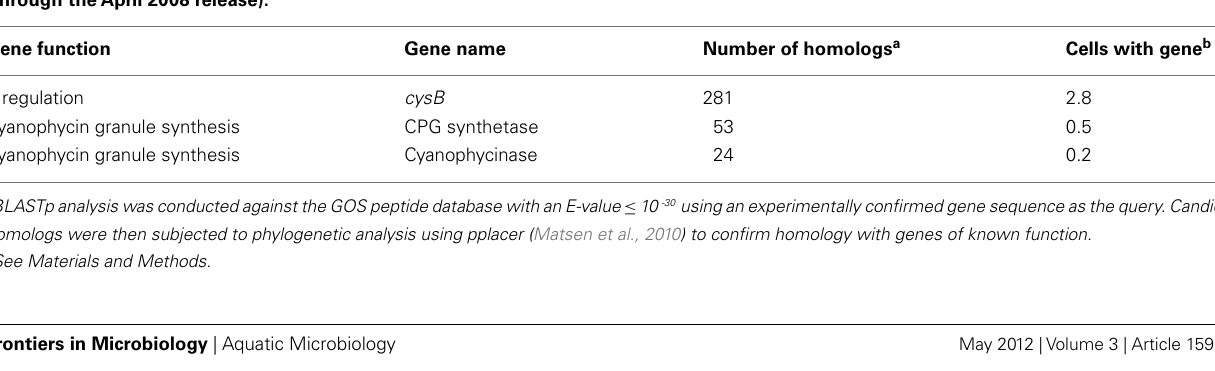
(through theApril 2008